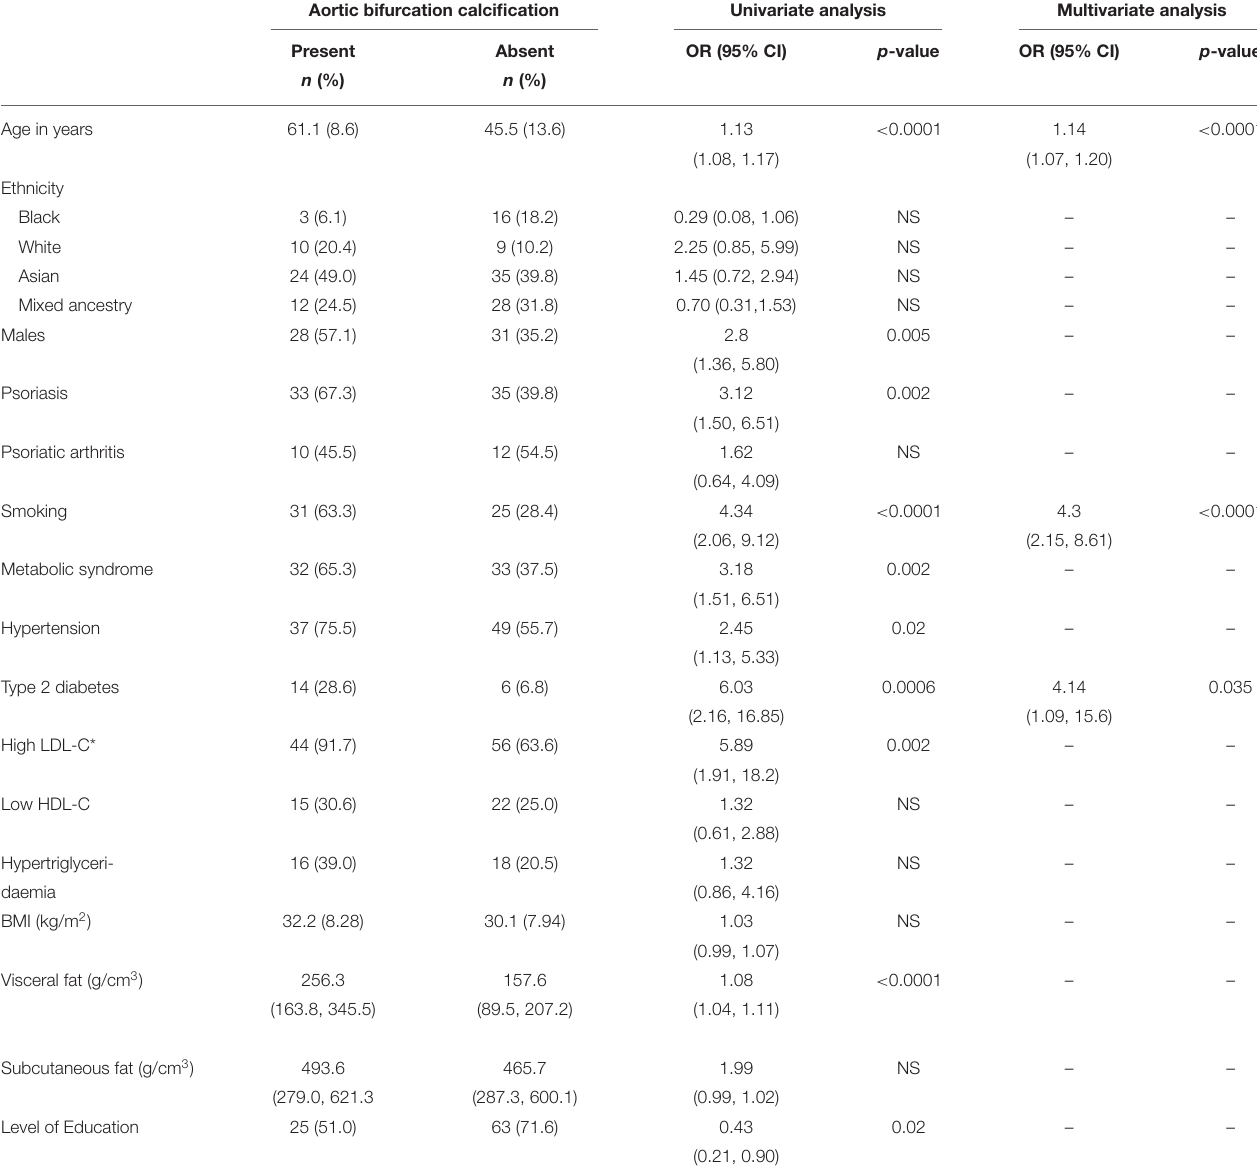
TABLE 3 | Predictors of abdominal aortic bifurcation calcification. Aortic bifurcation calcification Univariate analysis Multivariate